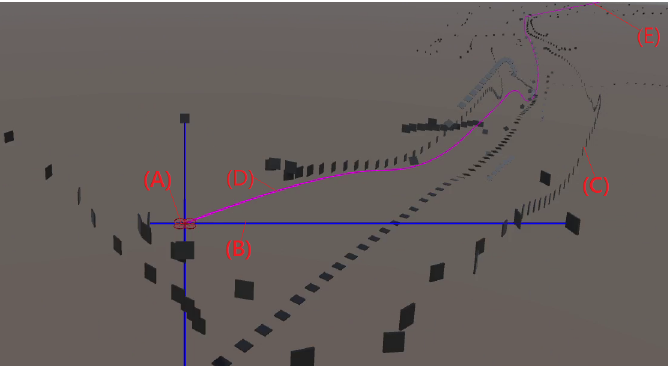
Figure 5. A 3D mapping of a building as transmitted by an actual BAT to the mapping station. BAT (A) is marked in red, its current ranging (B) is marked in blue rays, the path (D) of BAT is marked in magenta, and its starting point is marked as (E). The building 3D point-clouds (C) is marked by black